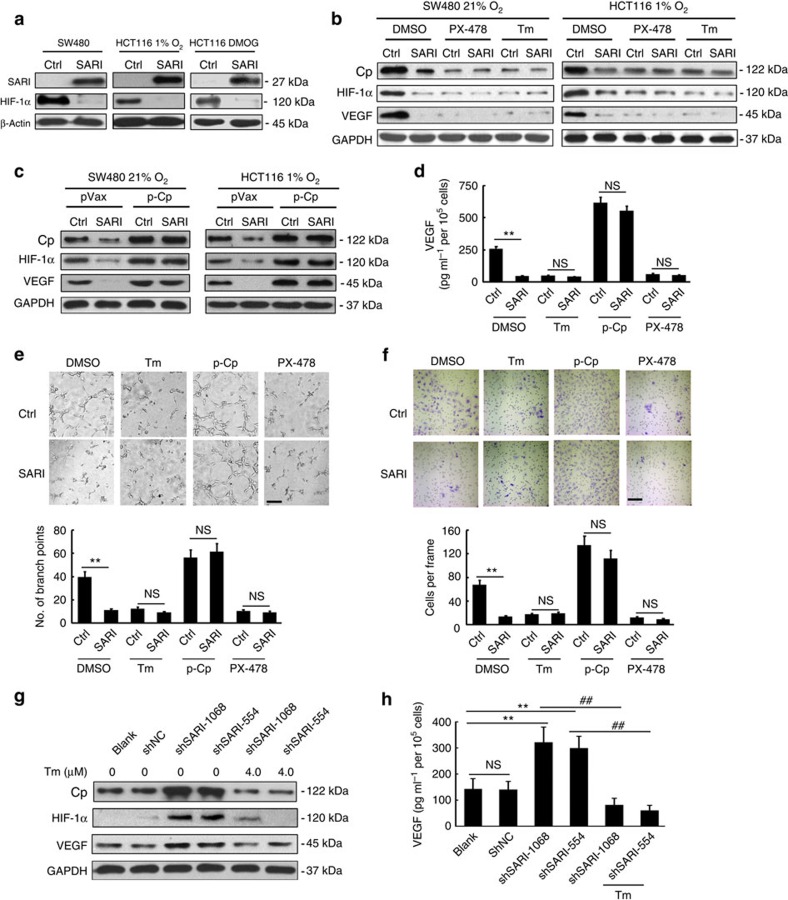
SARI inhibits angiogenesis through inhibiting Cp expression and the activity of the HIF-1α/VEGF axis.(a) Immunoblots of SARI and HIF-1α expression in SW480 and HCT116 cells after stable expression of SARI. HCT116-control and HCT116-SARI cells were incubated under 1% O2 for 48 h or treated with DMOG for 24 h. β-Actin was used as a loading control. (b) Immunoblots of Cp, HIF-1α and VEGF expression in control and SARI cells with or without PX-478 (45 μM) or Tm (4.0 μM) treatment under normoxia and hypoxia. GAPDH was used as the loading control. (c) Immunoblots of Cp, HIF-1α and VEGF expression in control and SARI cells after transfection with or without p-Cp plasmid under normoxia and hypoxia. GAPDH was used as the loading control. (d) Expression of VEGF exacted by SW480-control and SW480-SARI cells with or without Tm (4.0 μM) and PX-478 (45 μM) treatment, after transfection with or without Cp expression plasmid (n=3; **P<0.01, NS, no significant difference; Student's t-test). (e) Endothelial tube formation estimation following the incubation of HUVECs with conditioned medium from SW480-control and SW480-SARI cells with or without Tm treatment (4.0 μM) and PX-478 (45 μM), after transfection with or without Cp expression plasmid. The number of branches were quantified (n=5; ** P<0.01; NS, no significant difference; Student's t-test). Scale bar, 50 μm. (f) Representative photomicrographs of HUVECs that have invaded through Matrigel chambers after incubation with conditioned medium from SW480-control and SW480-SARI cells with or without Tm treatment (4.0 μM) and PX-478 (45 μM), after transfection with or without Cp expression plasmid. Quantification of HUVECs that have invaded through Matrigel chambers (n=5; **P<0.01; NS, no significant difference; Student's t-test). (g) Immunoblots of Cp and HIF-1α expression in HCT15, HCT15-shNC, HCT15-shSARI-1068 and HCT15-shSARI-554 cells with or without Tm (4.0 μM) treatment. GAPDH was used as a loading control. (h) Expression of VEGF exacted by HCT15, HCT15-shNC, HCT15-shSARI-1068 and HCT15-shSARI-554 cells with or without Tm treatment (4.0 μM) was measured by ELISA (n=3; **P<0.01; ##P<0.01; analysis of variance analysis).